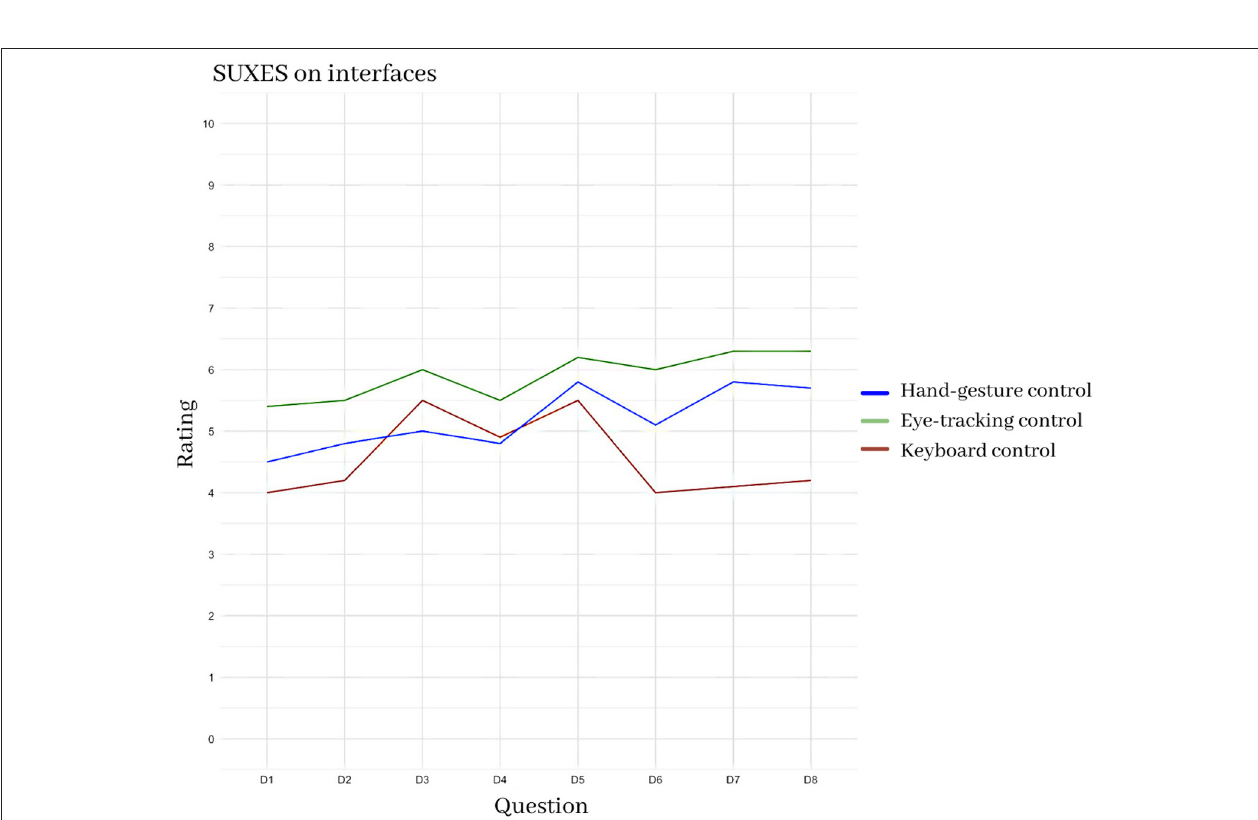
FIGURE 13 | Comparison of the average scores for the SUXES questionnaire for the different interfaces, and interface components: keyboard, eye-control, hand control.